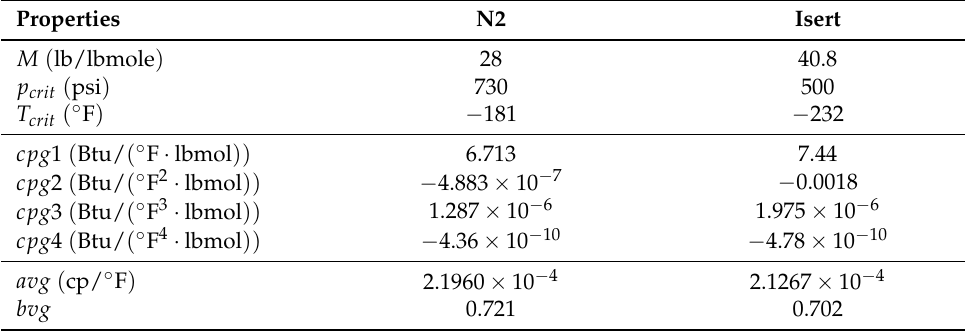
Table 7. NCG property data for Example 2.